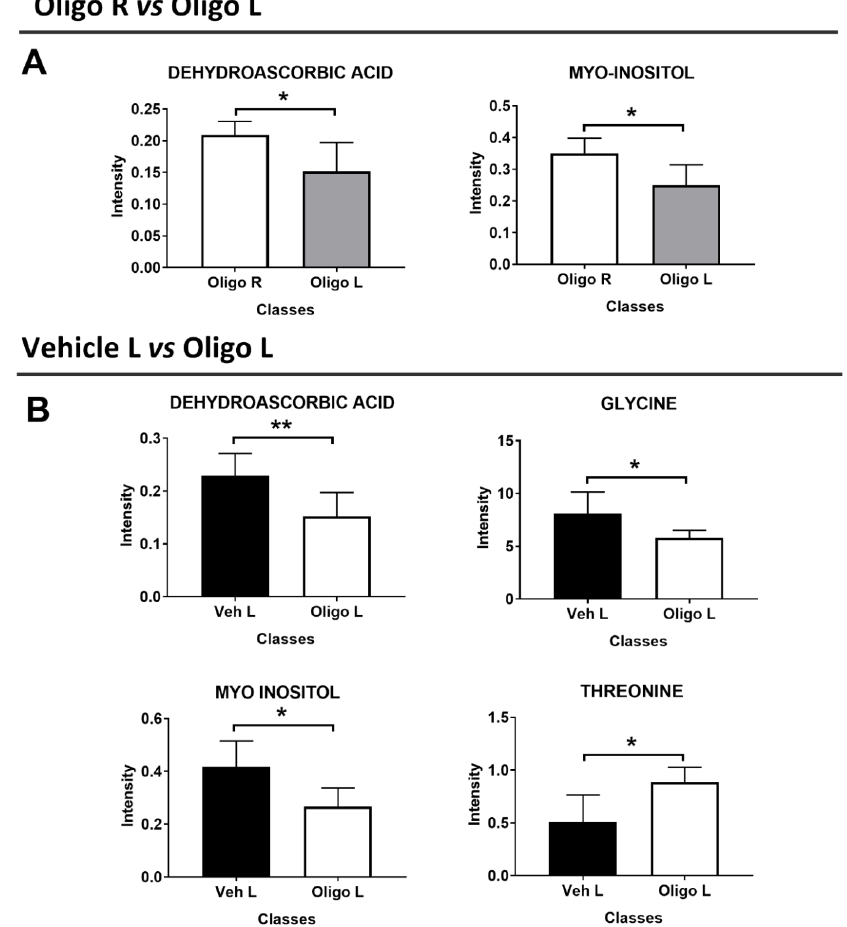
Figure 4. Discriminant metabolites resulting from the multivariate analysis of the mesencephalon between Oligo R vs. Oligo L ( A ), and Veh L vs. Oligo L ( B ). U-Mann Whitney analysis was performed to evaluate the statistical significance. * = p -value < 0.05; ** = p -value <0.001.